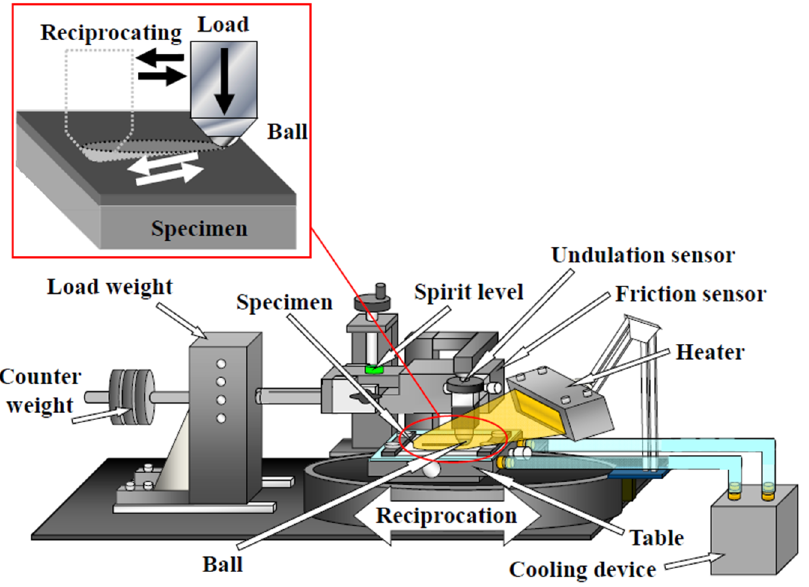
Figure 1. Load increase and decrease reciprocation friction test.